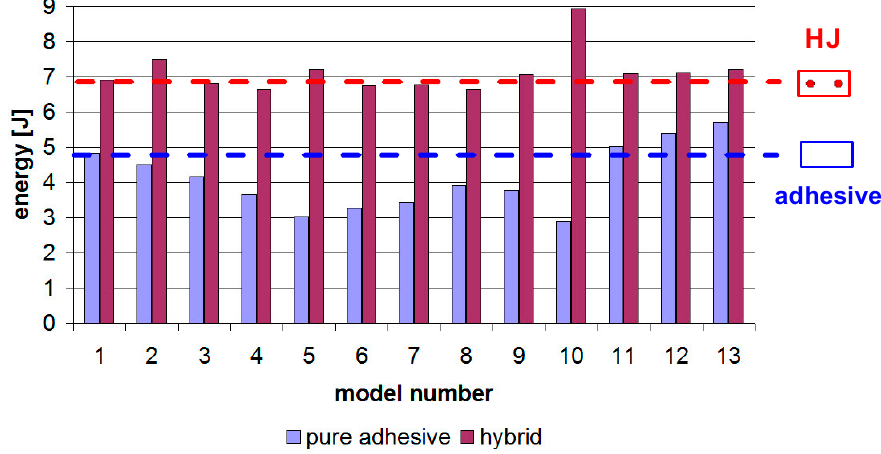
Figure 8. Energy in pure adhesive and hybrid joints.